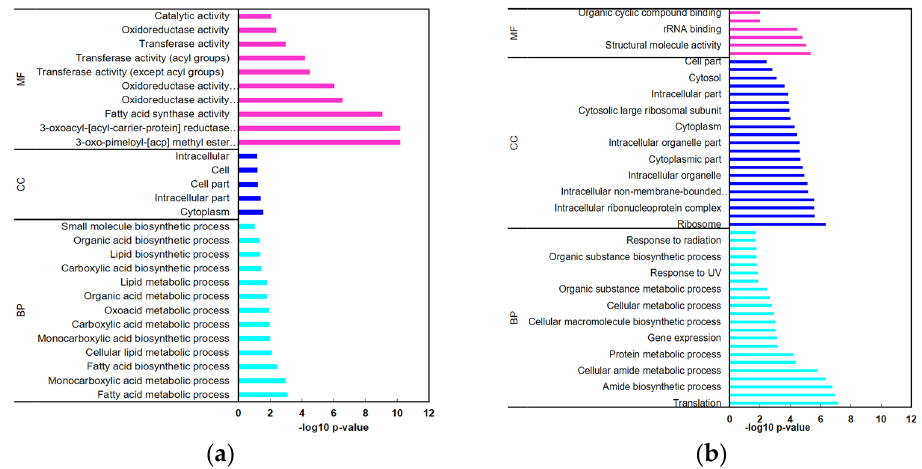
Figure 4. Functional annotation of the DEGs in the mesophilic B. cereus group strain ( a ) and the psychrotolerant B. cereus group strain ( b ) grown at 10 °C compared to growth at 30 °C. GO term analyses of transcriptomes categorized as Biological Process (BP), Cellular Component (CC), and Molecular Function (MF).